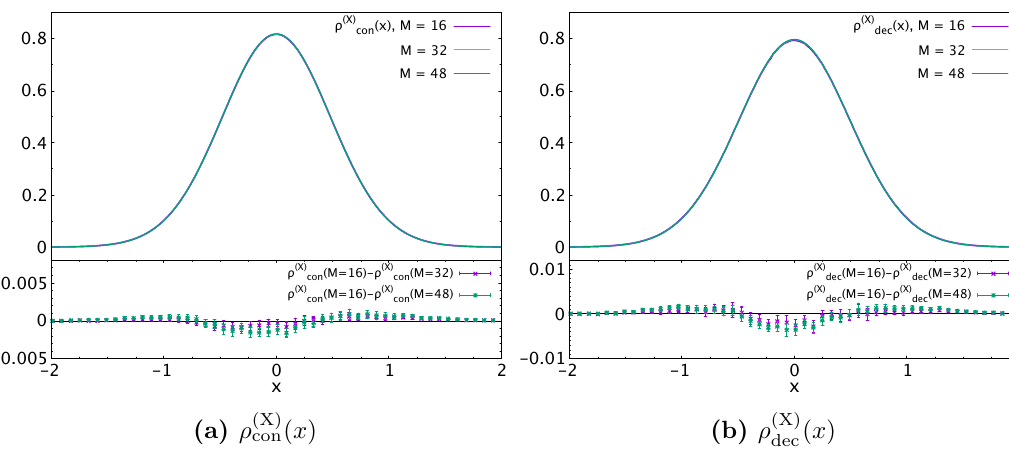
Figure 15. Yang-Mills matrix model, constrained simulations, N = 64 , L = 24 , T = 0 . 885 . ρ (X) con ( x ) and ρ (X) ( x ) obtained from different values of N and M . The error bars in each figure are obtained dec by jackknife analysis.